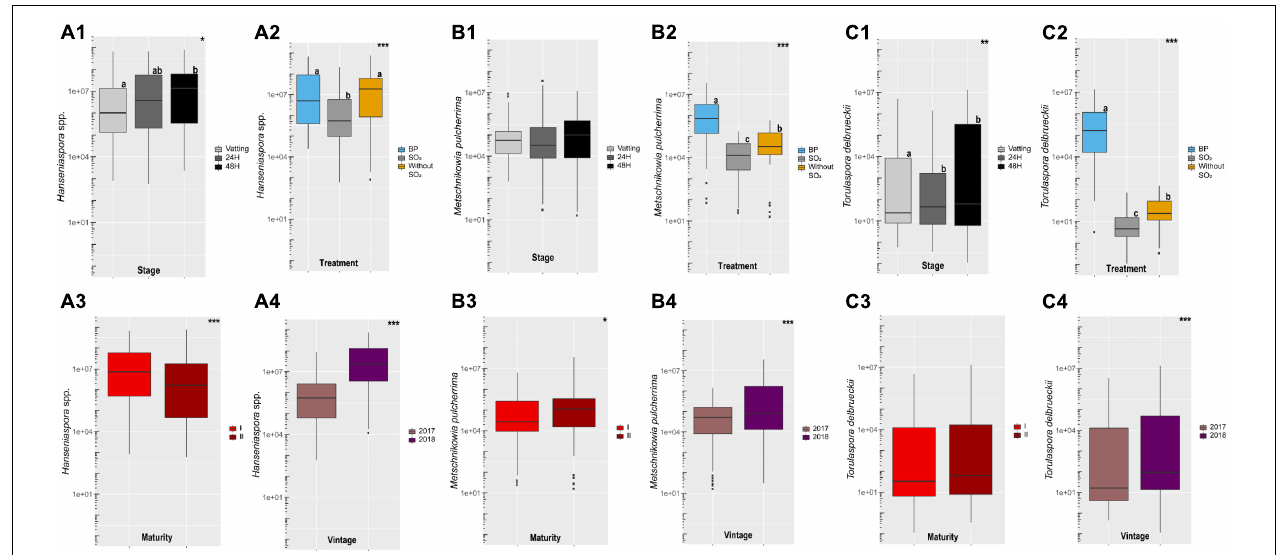
FIGURE 2 | Boxplot of population levels obtained by Q-PCR (cells/mL) for Hanseniaspora spp. (A) , Metschnikowia pulcherrima (B) , Torulaspora delbrueckii (C) according to Stage (1) (Vatting, 24H and 48H of maceration), Treatment (2) (Bioprotection (BP), SO 2 and Without SO 2 ), Maturity (3) [technological (I) and advanced maturities (II)] and Vintage (4) (2017 and 2018) parameters. Significance is indicated as follow: * significant at 5%, ** significant at 1%, *** significant at 0.1% (ANOVA and T-test) and boxplot with different letters differ significantly (HSD-test).